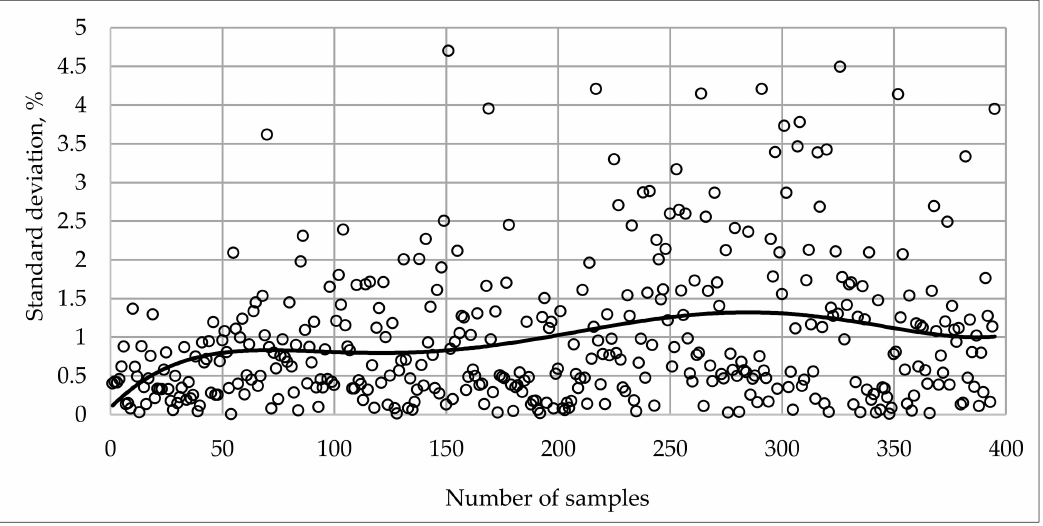
Figure 4. Standard deviation from mean values for two sub-samples of the same sample and mean trendline curve.